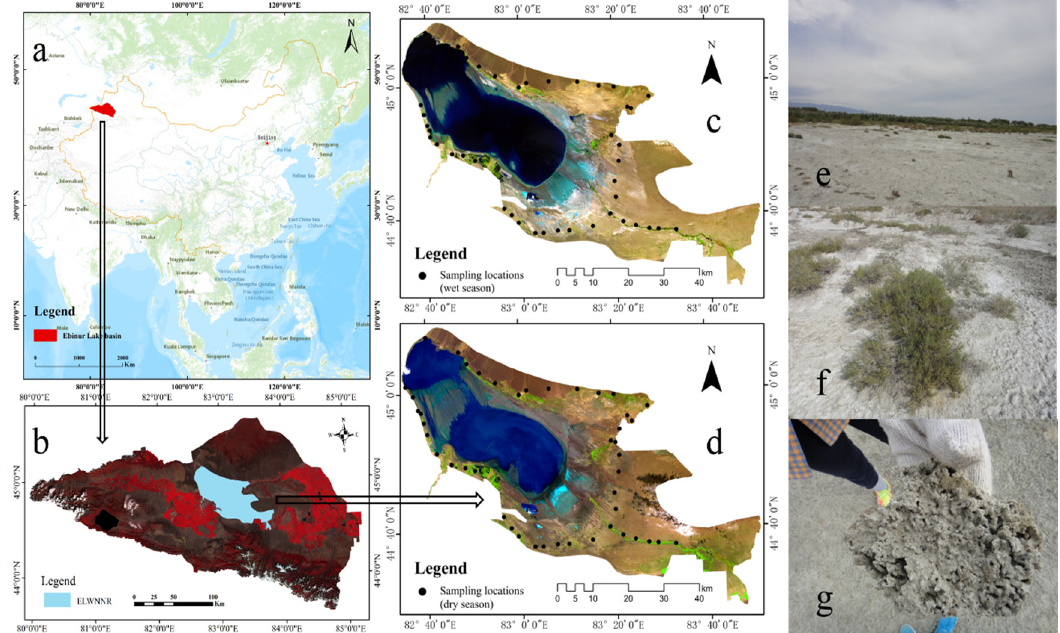
Figure 1. Location maps of the study area: ( a ) location map of Ebinur Lake basin in China, where the map of China uses the network base map that comes with Arcgis 10.3; ( b ) Ebinur Lake basin; ( c ) the wet season of ELWNNR; ( d ) the dry season of ELWNNR; ( e ) large areas of salinized soil; ( f ) halophytic vegetation grows in salinized soil; and ( g ) a large salt crust. ELWNNR, Ebinur Lake Wetland National Nature Reserve.